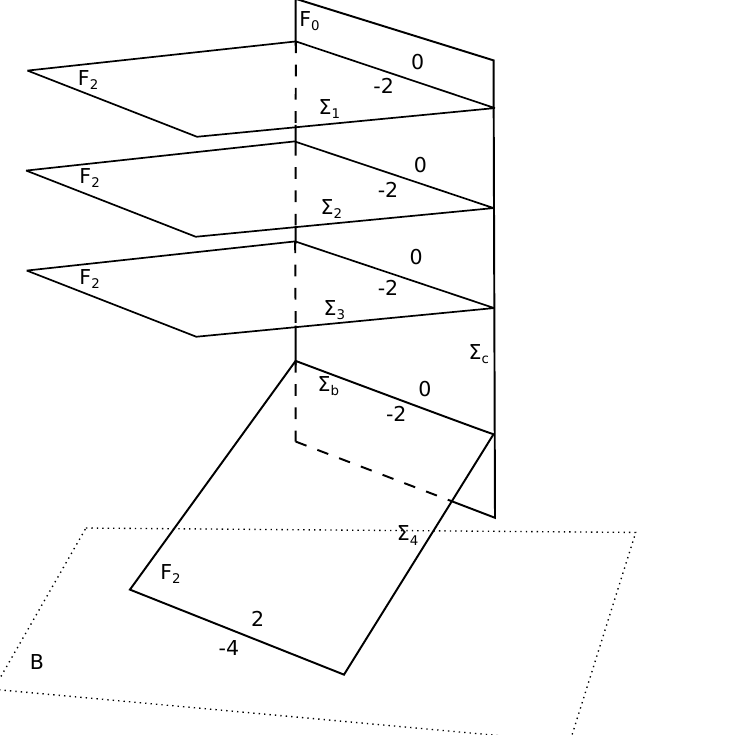
Figure 3. Compact curves and compact divisors in the elliptic (cid:12)bration over O ( (cid:0) 4) ! P 1